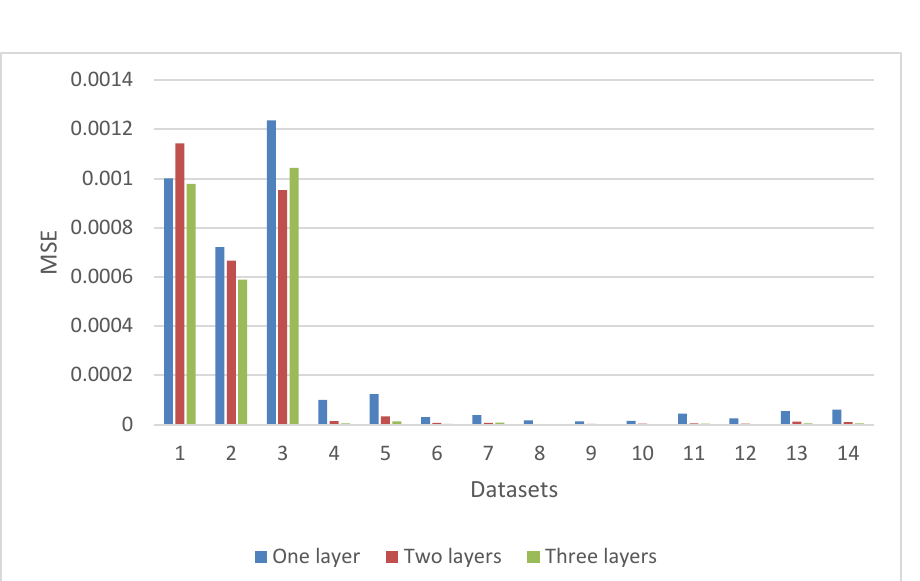
Figure 9. MSE for the three neural network models.